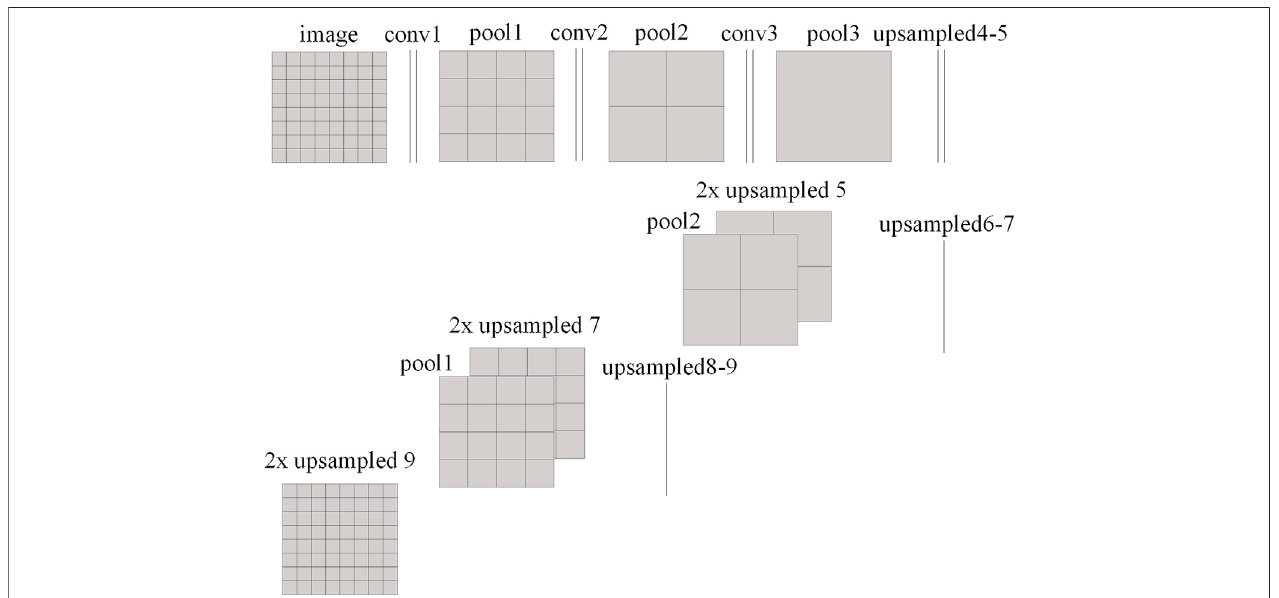
FIGURE 5 | Schematic diagram of the FCN structure.